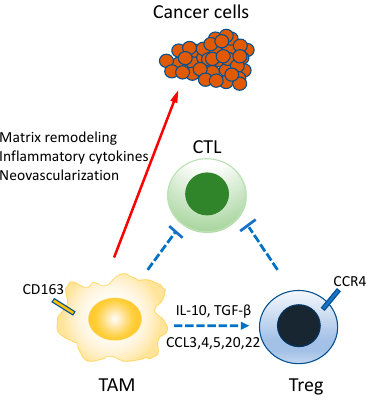
Figure 8. Roles of TAM in the tumor environment. TAM has the nature of M2-macrophage, directly suppressing the CTL, but also producing mediators involved in neovascularization, tumor infiltration / metastasis, andTregmigration / maintenance. Theimmunosuppressiveactivityisrepresented as a blue line and the tumor-stimulating activity as a red